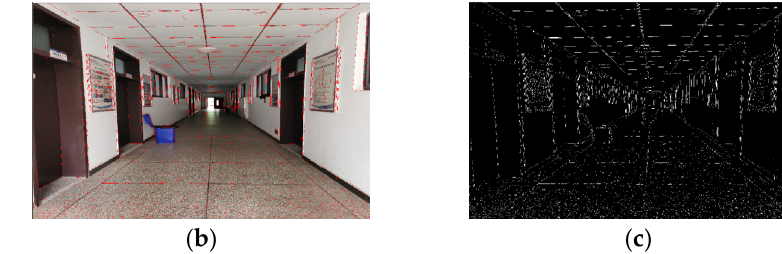
Figure 3. LSD line segment extraction effect: ( a ) indoor promenade scene; ( b , c ): LSD line segment extraction effect.